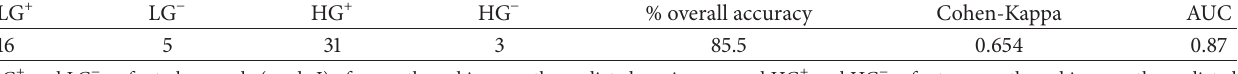
Table 3: Contingency table of predicting the grade of laryngeal squamous cell carcinomas by the nonlinear logistic regression equation. LG + LG − HG + HG − % overall accuracy